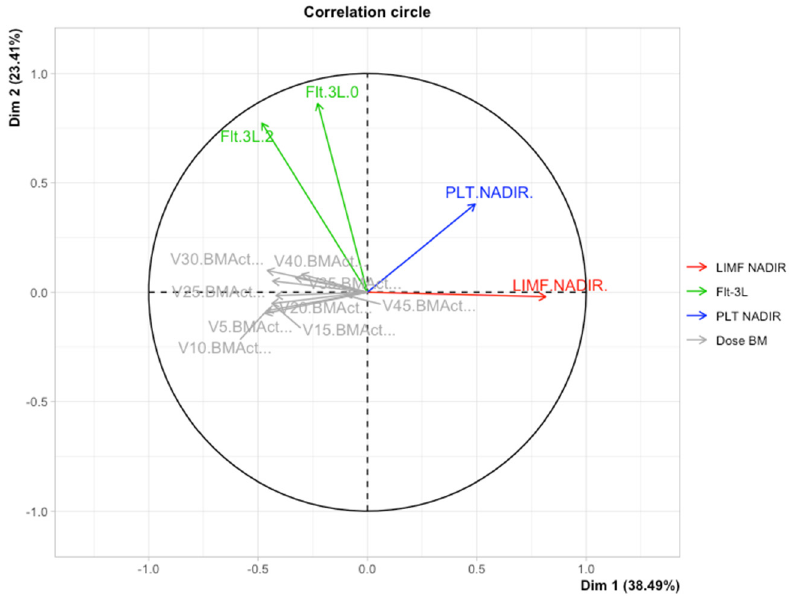
Figure 2. Multiple factorial analysis correlation circle of dose volume parameters, platelet and lymphocyte nadirs, and Flt-3L concentration. Dimension 1 (explained by 38.49% variance) shown on the x -axis, dimension 2 (explained by 23.14% variance) shown on the y -axis.